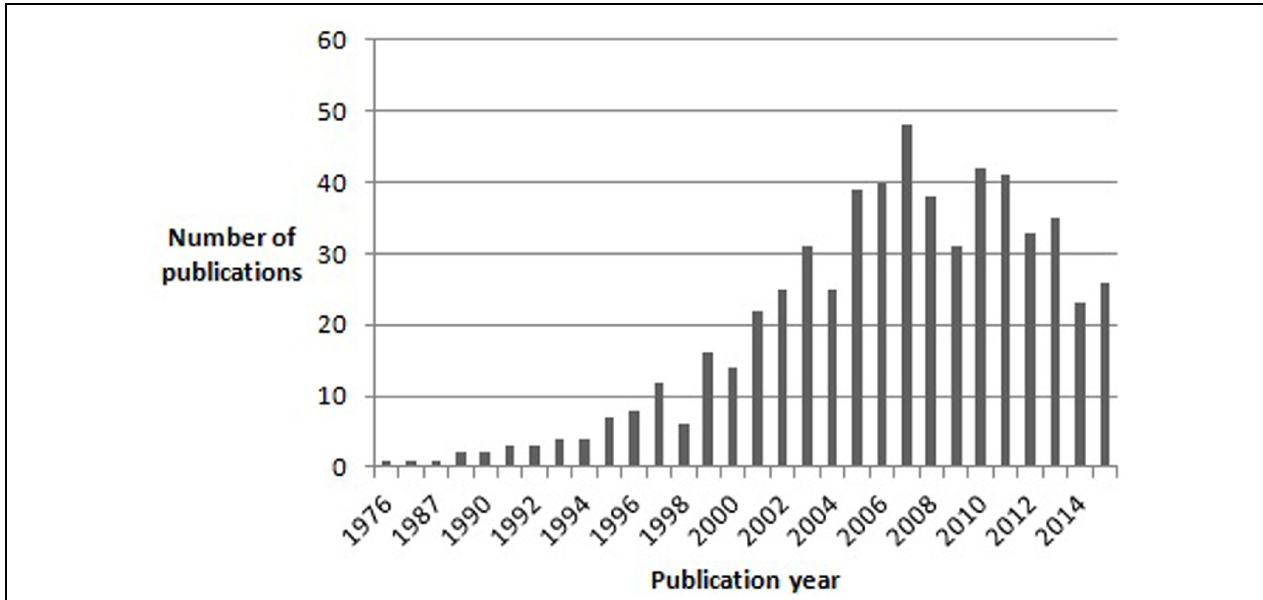
FIGURE 1 | Results of a pubmed search for articles containing the word “Asperger” in the title, published between 1976 and November